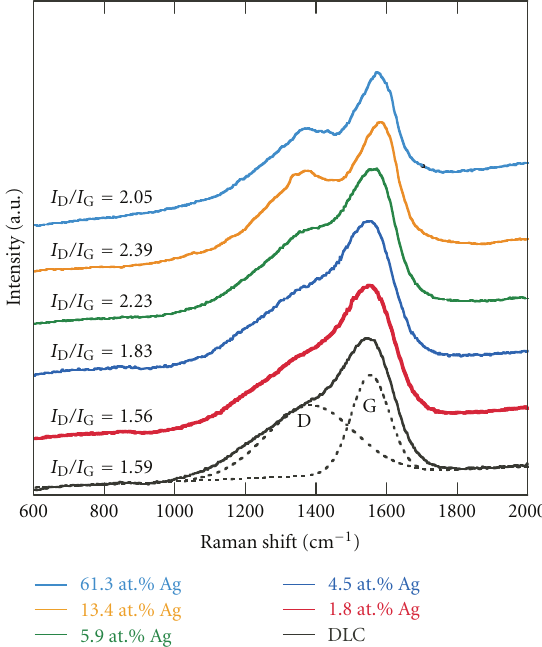
Figure 3: Raman spectra of Ag-DLC films containing di ff erent amounts of